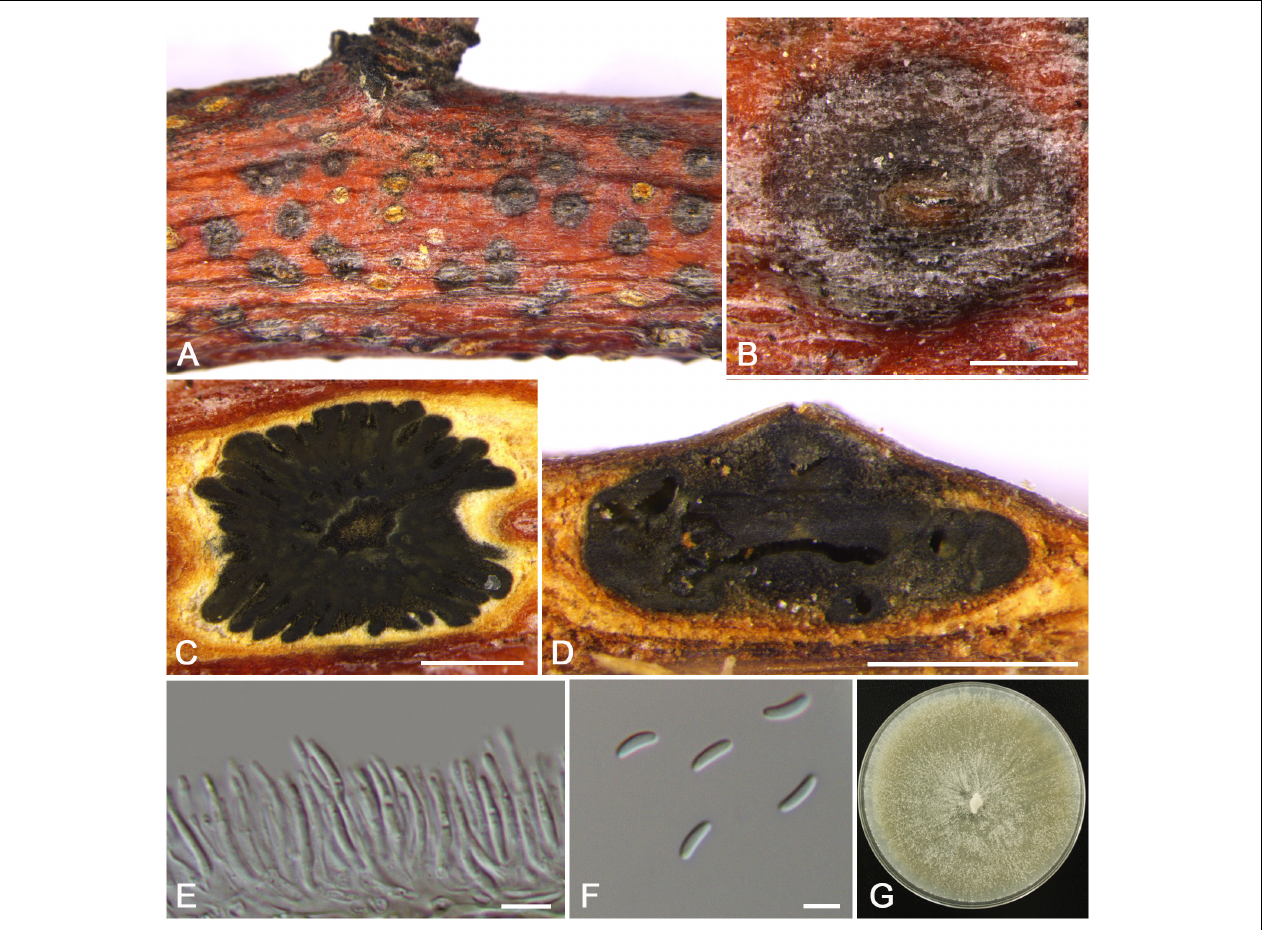
FIGURE 9 | Morphology of Cytospora parasitica from Malus pumila (CF 20197714). (A,B) Habit of conidiomata on twig. (C) Transverse section of conidioma. (D) Longitudinal section through conidioma. (E) Conidiophores and conidiogenous cells. (F) Conidia. (G) Colonies on PDA for 2 weeks. Bars: (B–D) = 500 µ m; (E) = 10 µ m; (F) = 5 µ